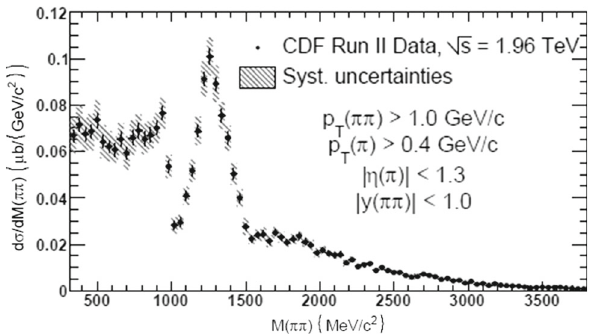
Fig. 1 Invariant mass distribution of pion pairs measured by the CDF Collaboration (Figure taken from Ref. [1])